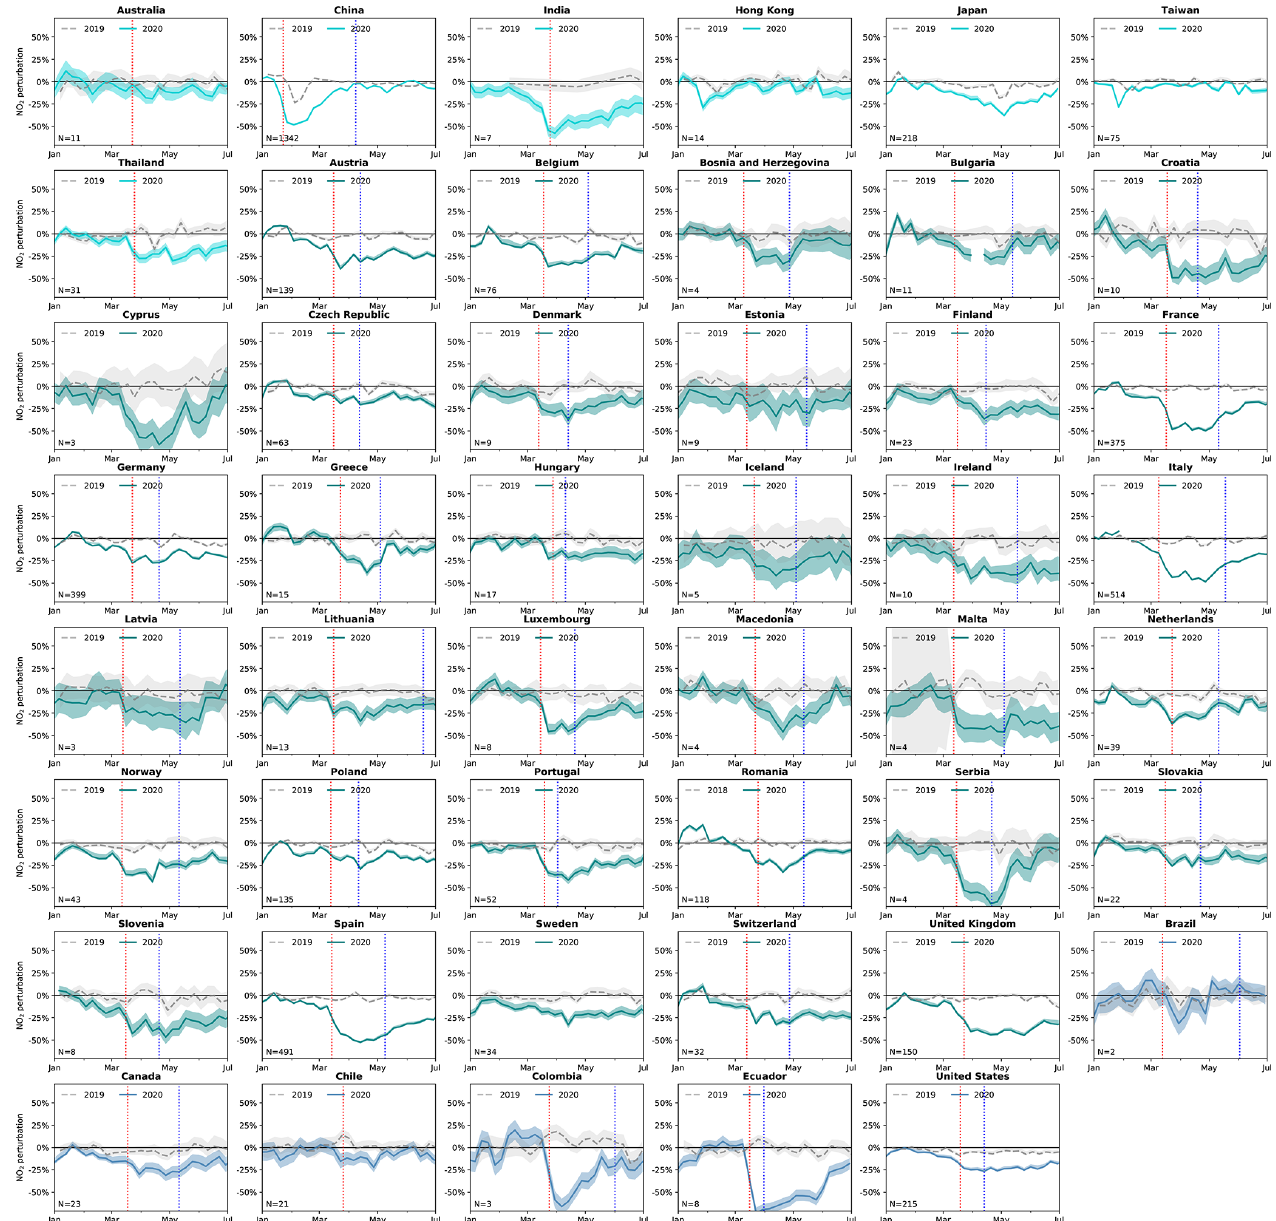
Figure 5. The 7d average fractional difference between observed NO 2 and the BCM predictions for 46 countries between 1 January through 30 June, aggregated from all sites across each country (number of sites given at the bottom left of each panel). The thick line indicates the mean across all sites for the first half of 2020, with the shaded area representing the uncertainty estimate. Differing colors indicate differing regions (cyan: Asia and Australia; green: Europe; blue: Americas). The dashed grey line indicates the equivalent average for the same 6 month period in 2019 (note that 2019 data was included in the training). The dashed vertical red line indicates COVID-19 restriction dates, and the blue line indicates the beginning of easing